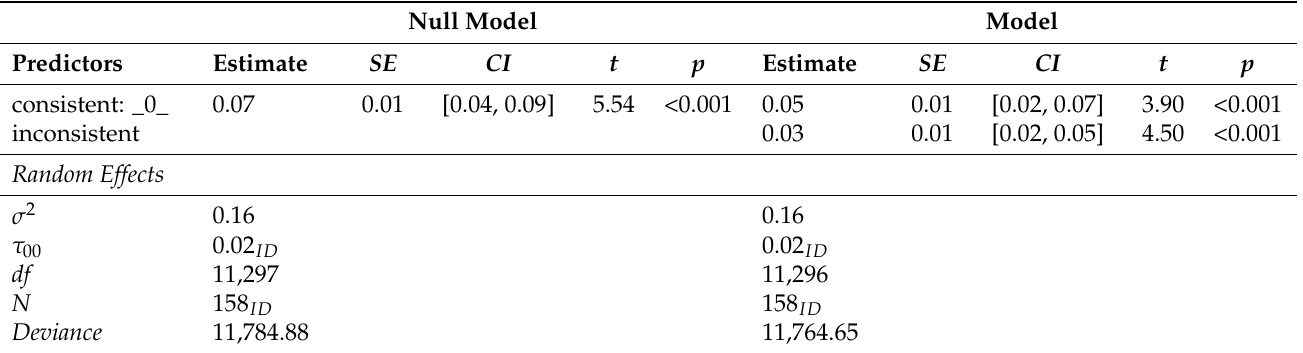
Table A5. Mixed model of the influence of binary stimuli conditions on the emospace arousal vector response. Null Model